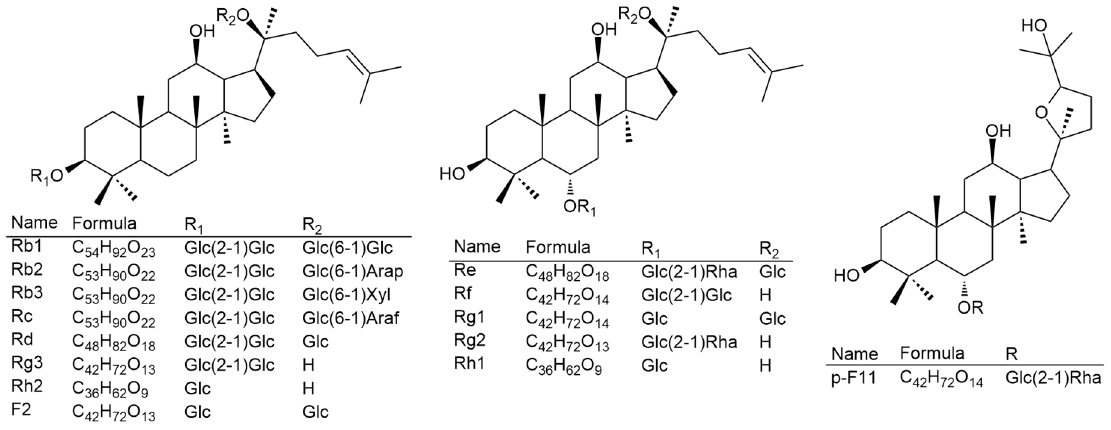
Figure 1. The chemical structures of 14 ginsenoside reference standards.